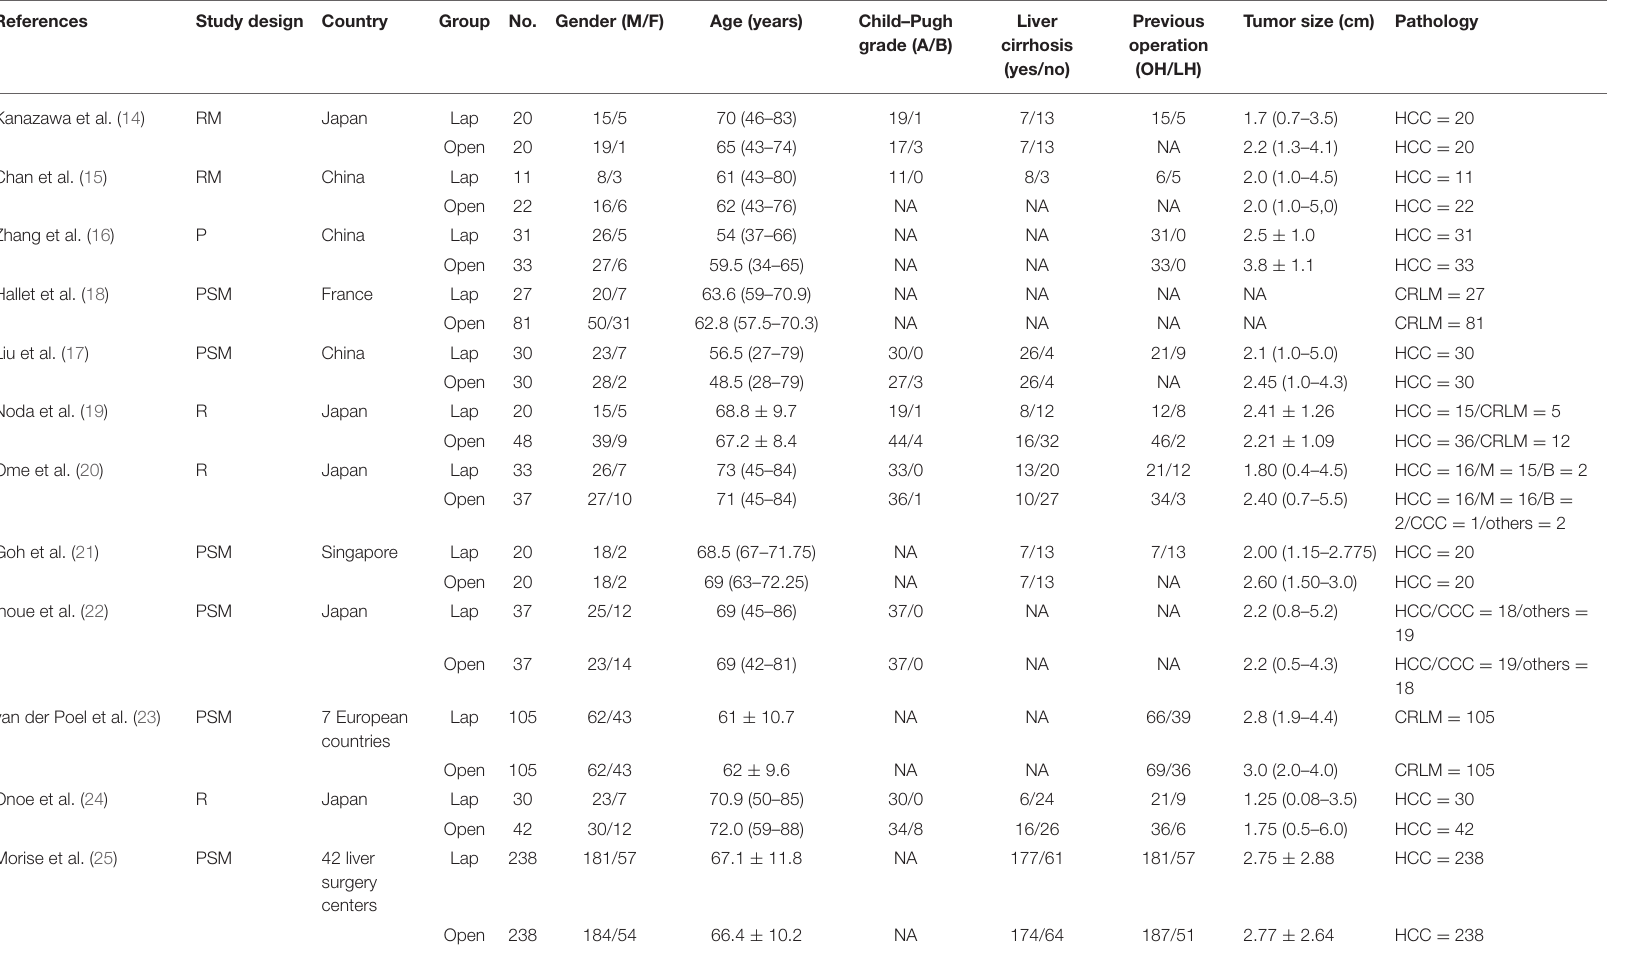
TABLE 3 | Summary of characteristics of included